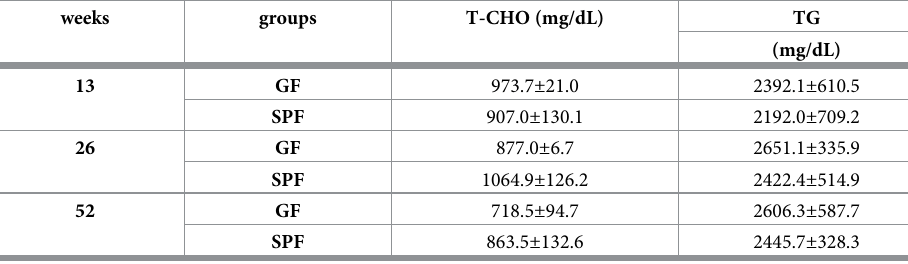
Values are expressed as mean ± SD. T-CHO: total cholesterol; TG: